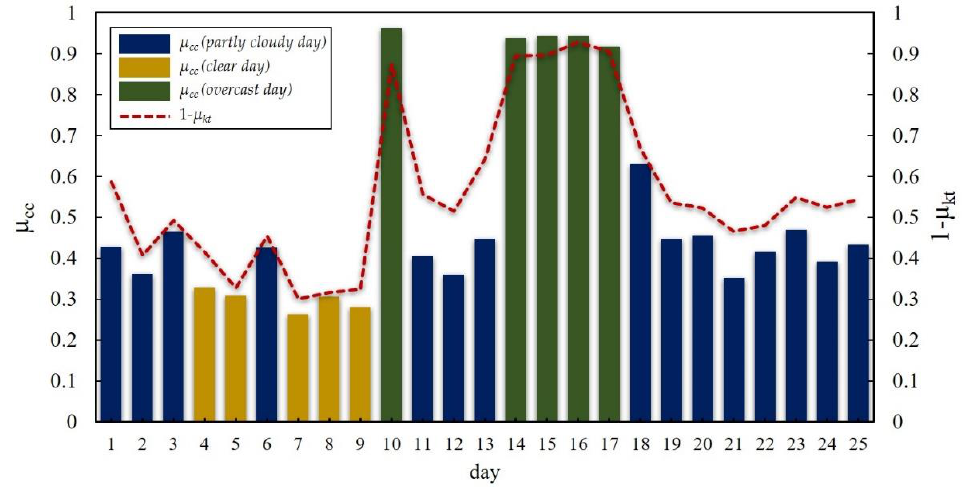
Figure 7. Mean cloud cover distribution and mean clear-sky index for each day data. Note : the mean clear-sky index was changed by the opposite original value to follow the cloud cover definition.